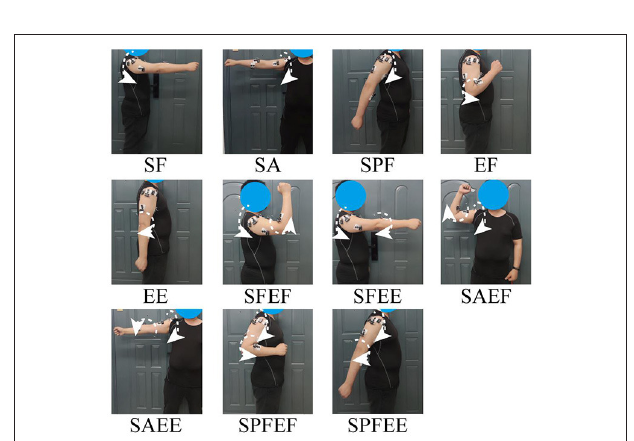
FIGURE 3 | Examples of the trajectories of the 11 motions performed by the subjects in this